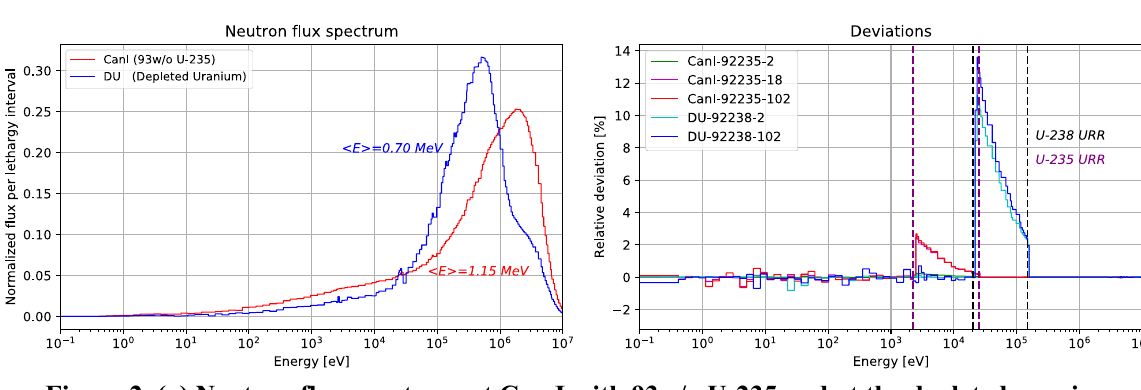
Figure 2. (a) Neutron flux spectrum at Can I with 93w/o U-235 and at the depleted uranium reflector of HEU-COMP-INTER-003-001 benchmark. (b) Relative differences in cross-sections with and without PT in the URR in those